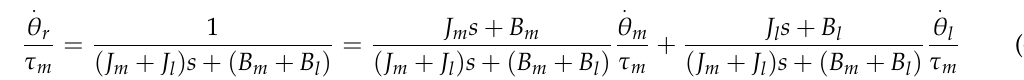
. . . θ  , from θ  , and from θ  . τ to τ to τ to θ τ θ τ θ m , from m to m to r . l , and from m l r m m m . θ r can be obtained by: